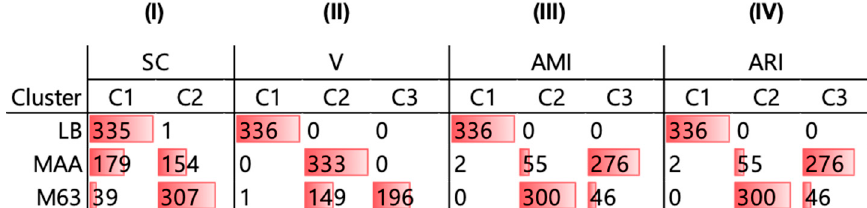
Figure 3. Clusters of the growth curves. The four benchmarks, SC, V, AMI and ARI are indicated in I – IV , respectively, according to the best combinations of α and N indicated in Figure 2. The determined clusters are shown as C1, C2, and C3. The growth curves categorized in different clusters are counted and correspond to the LB, MAA, and M63 growth media. The resultant numbers of the growth curves are indicated with both the values and the color bars.